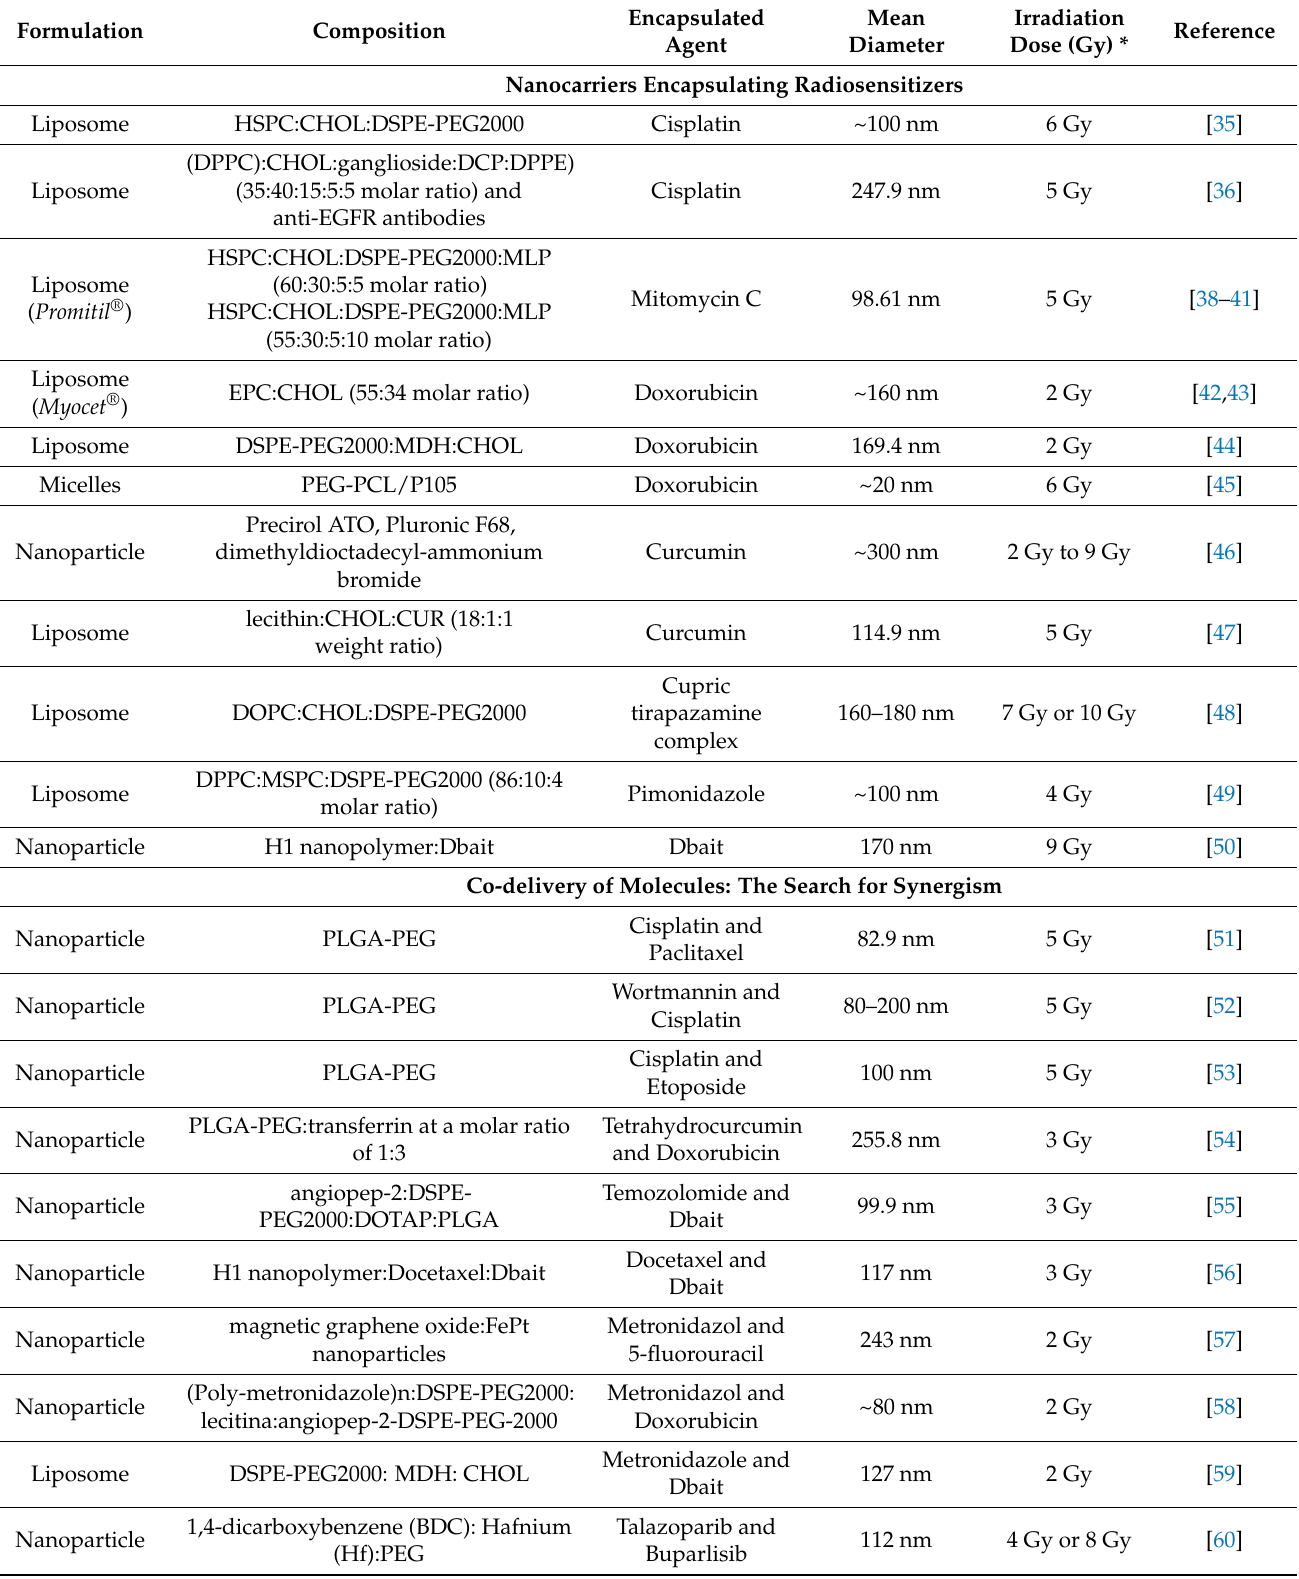
Table 1. Nanocarriers designed to be used in combination with